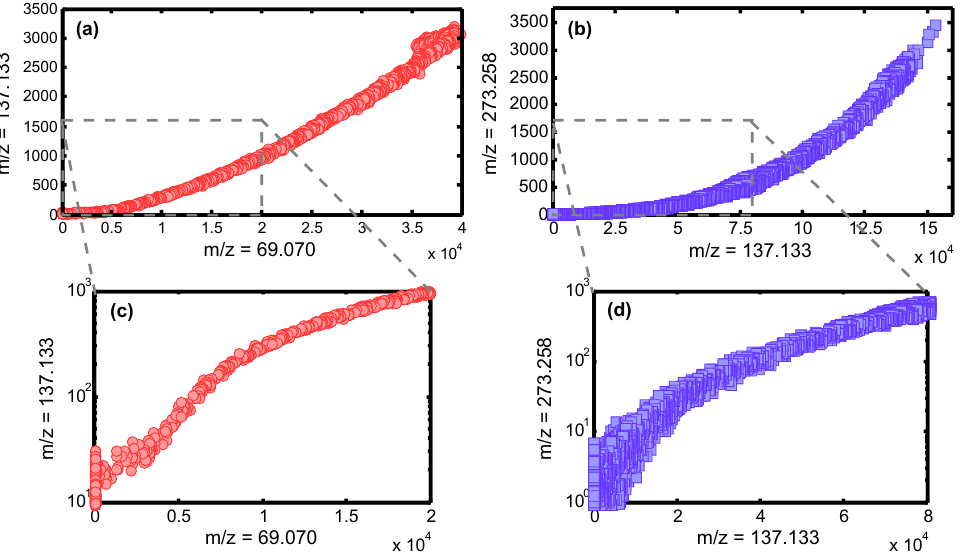
Figure 3. Comparison of the correlation plots of the 2016 chamber experiment (a) and 2016 evaporation experiment (b) for m/z = 69.070 vs. m/z = 137.133 (red) and m/z = 137.133 vs. m/z = 273.258 (purple). Panel (a) shows the correlation over the initial chamber experiment without the cryotrap and before the addition of ozone. Panel (b) shows the correlation over the entire evaporation experiment. Panels (c) and (d) focus on the lower concentration range. For the pure secondary association reaction (b, d) a clear quadratic dependency is observed, while for the chamber experiment (a, c) two overlapping processes – especially in the lower concentration regime – take place before the cluster formation becomes the dominant pathway at higher